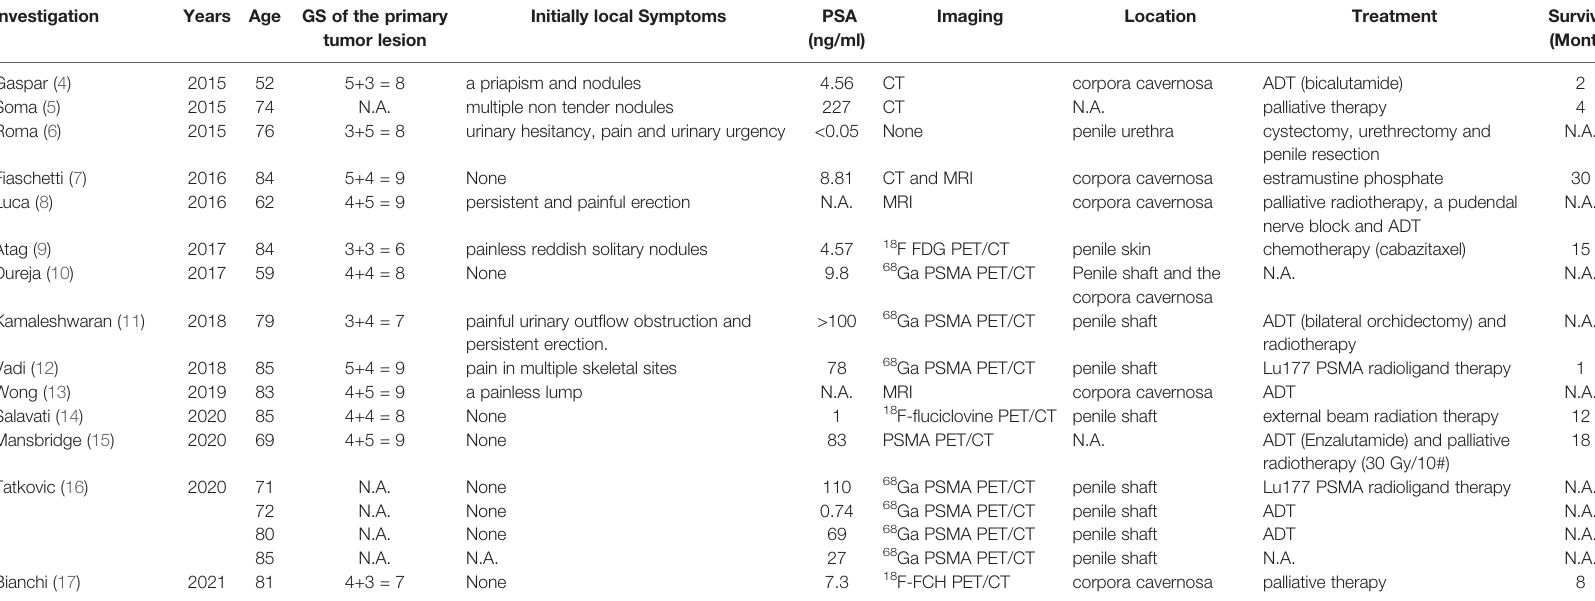
TABLE 1 | Reported Cases of Penile Metastases from Prostate Cancer in the Past Few Years.